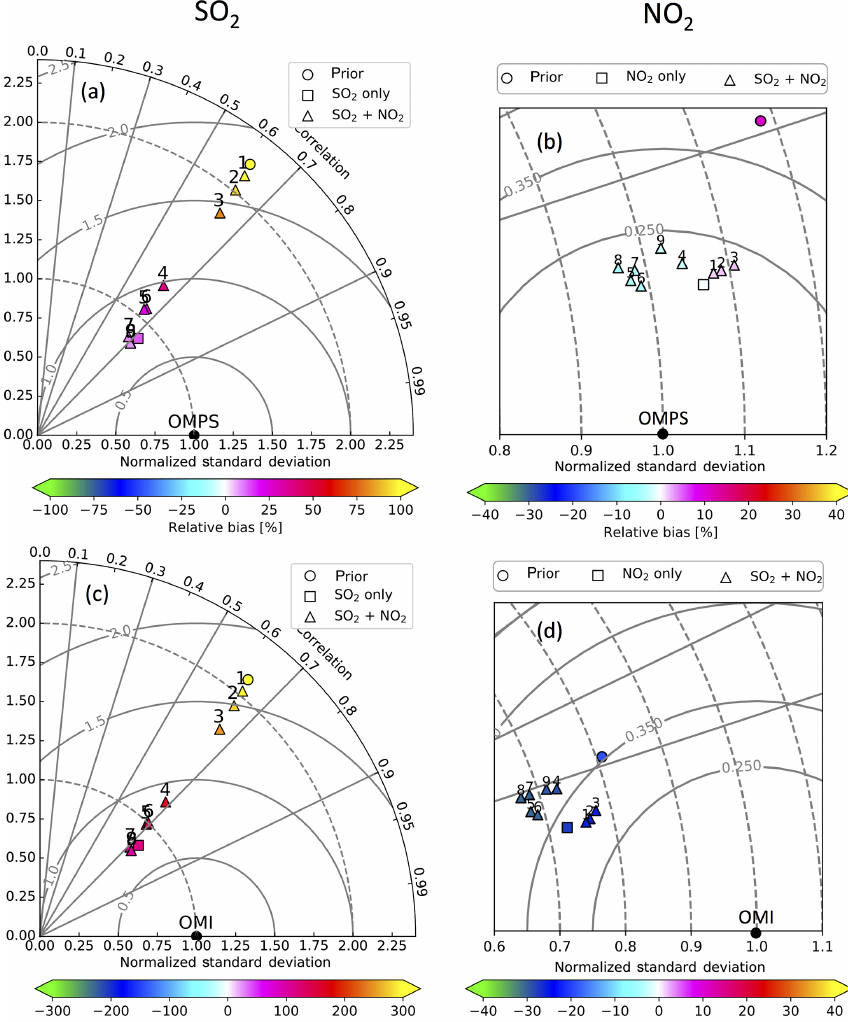
Figure 8. Taylor diagram comparing GEOS-Chem simulation with OMPS ( a for SO 2 and b for NO 2 ) or OMI ( c for SO 2 and d for NO 2 ) in October 2013. Circles, squares, and triangles represent GEOS-Chem simulations using prior MIX 2010 emissions, posterior emissions constrained by single species (E − SO 2 for a and c , E − NO 2 for b and d ), and posterior emissions constrained through joint inversion (E-joint), respectively. Different triangles labeled by numbers represent different γ values in Eq. (1), and 1 through 9 correspond to 20, 50, 100, 200, 300, 500, 1000, 1500, and 2000,